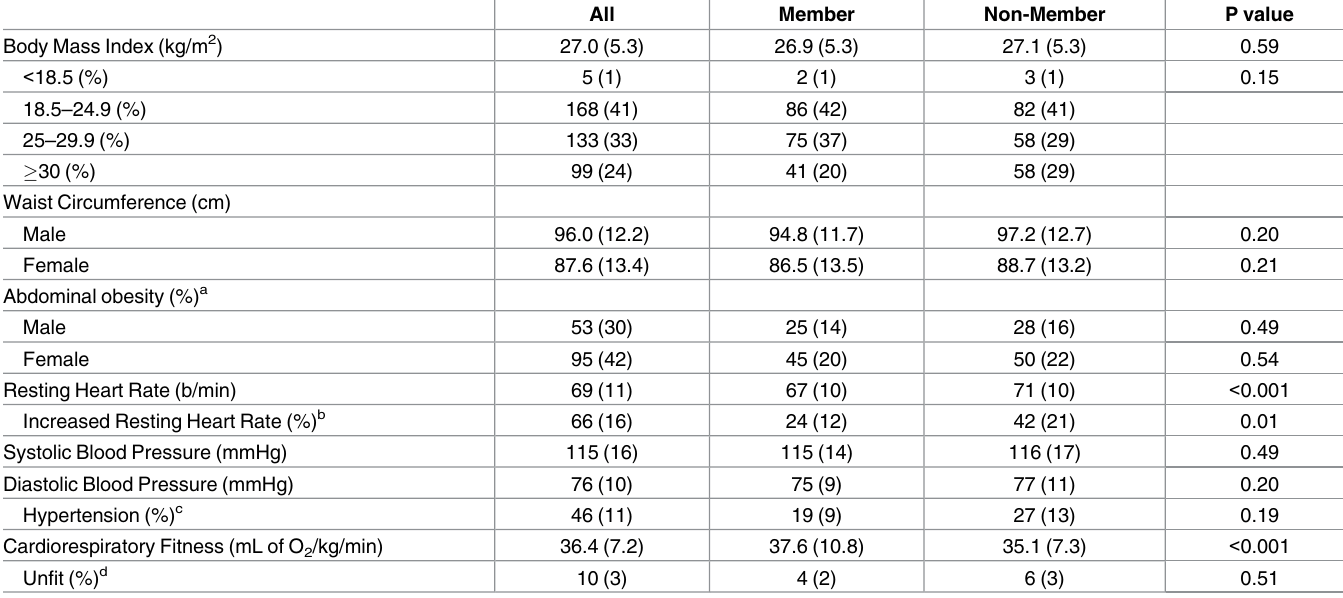
Table 2. Cardiovascular health outcomes by health club membership status.